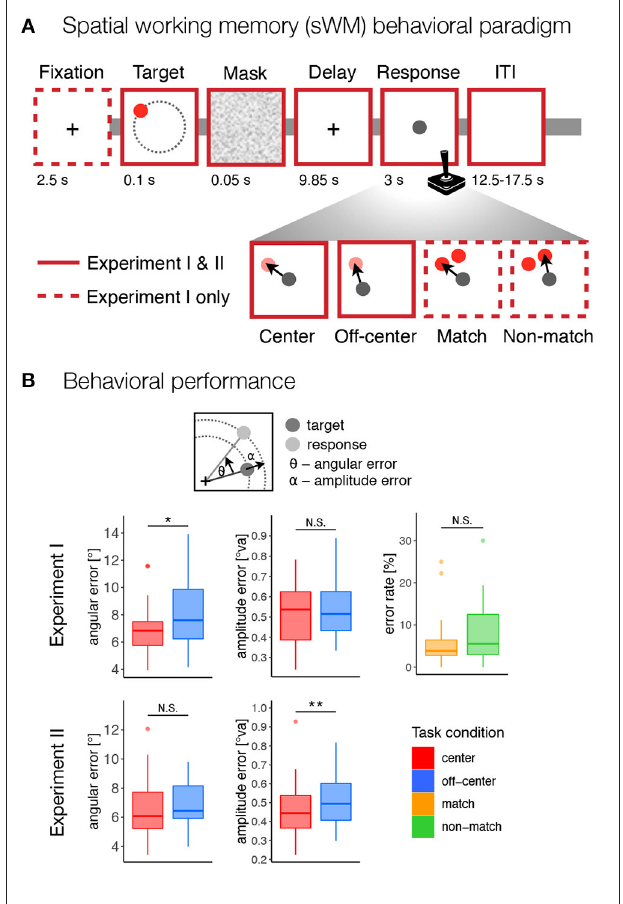
FIGURE 1 | Behavioral paradigm and performance. (A) The design of the spatial working memory tasks in both experiments. Participants were asked to remember the position of a briefly presented target stimulus (red disk) and, after a delay period, to move a gray disk using a joystick to the position of the remembered target or an indicated non-matching location. The task consisted of four conditions: center –move to target position from the center of the screen, off-center –move to target position from a random off-center position, match –move to the position of the probe at the target position, non-match –move to the position of the probe that does not match the target position. (B) Behavioral results for both experiments. For the match and non-match conditions, the response error was calculated as the percentage of incorrect responses. For the center and off-center conditions, the response error was calculated as the standard deviation of the angular and amplitude errors between the target and response positions, corrected for systematic biases. N.S., not significant; * p < 0.05, ** p < 0.01.